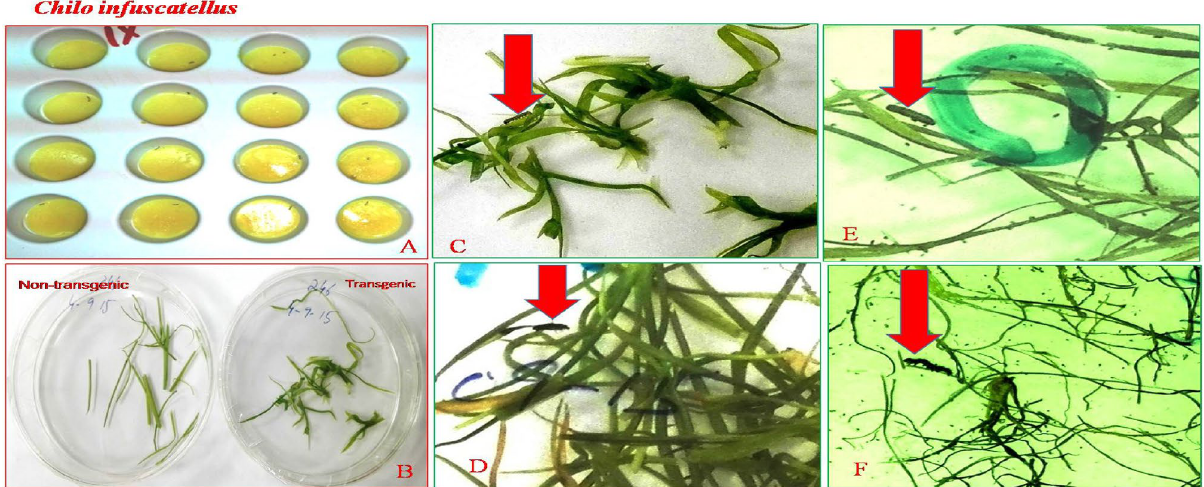
Figure 9. Leaf bioassay of transgenic plant leaves and control sugarcane plants. Plate ( A ) Chilo infuscatellus from CEMB-insectray Lab. Plate ( B ) Non-transgenic sugarcane and transgenic plant leaves after 20 days. Plate